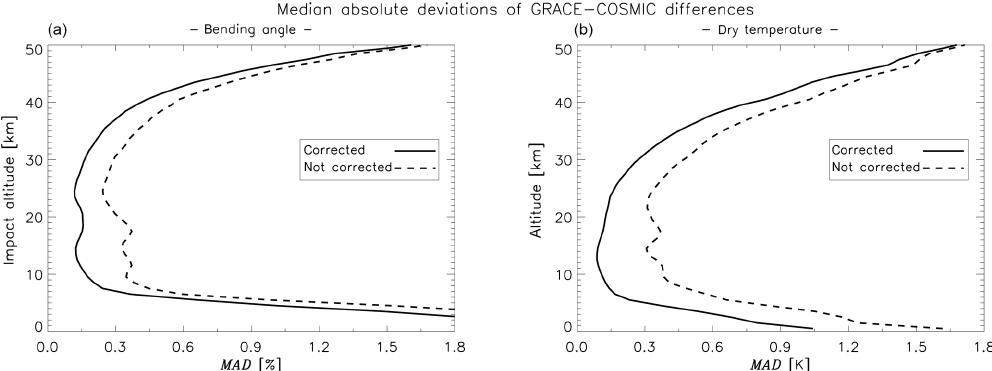
Figure 12. Median absolute deviations of GRACE–COSMIC differences computed from all monthly bins in 1km height intervals during the mission overlap period from March 2007 to December 2016: deviations for bending angles (a) and for dry temperature (b) . The solid lines show deviations with sampling-error correction applied, and the dashed lines show deviations without correction.